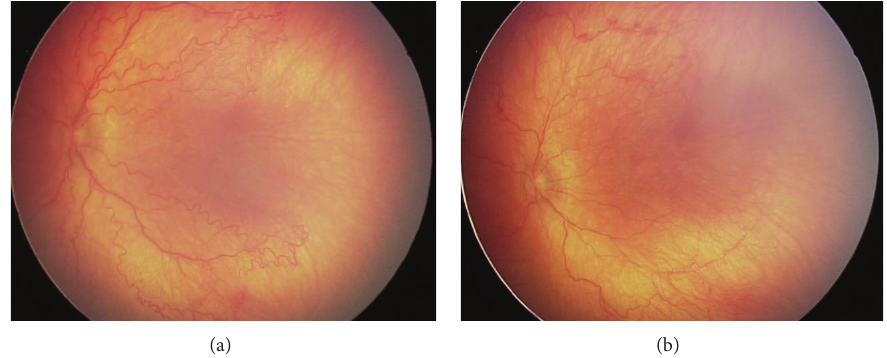
Figure 1: (a) AP-ROP prior to the bevacizumab injection: male infant, BW 1000 g, GA 28 w, treated with intravitreal bevacizumab at PMA of 34 weeks and PNA of 6 weeks. (b) Fundus photography 5 days after bevacizumab injection with venous dilatation and arteriolar tortuosity improvement in the posterior pole, showing plus disease